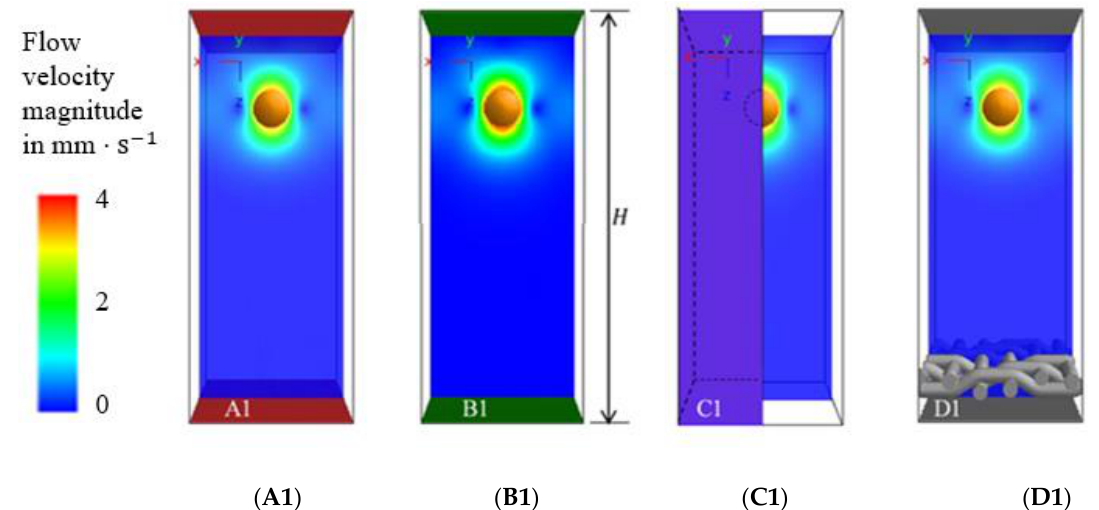
Figure 12. Particle settling behavior at time 𝑡 = 2 ms after it was dropped in different model arrangements, particle diameter 𝑑 𝑃 = 80 µm, model height 𝐻 = 800 µm, voxel length: ( A1 ) 𝜆 𝐴 = 2 µm, ( B1 ) 𝜆 𝐵 = 4 µm, ( C1 ) 𝜆 𝐶 = 2 µm, ( D1 ) 𝜆 𝐷 = 2 µm.